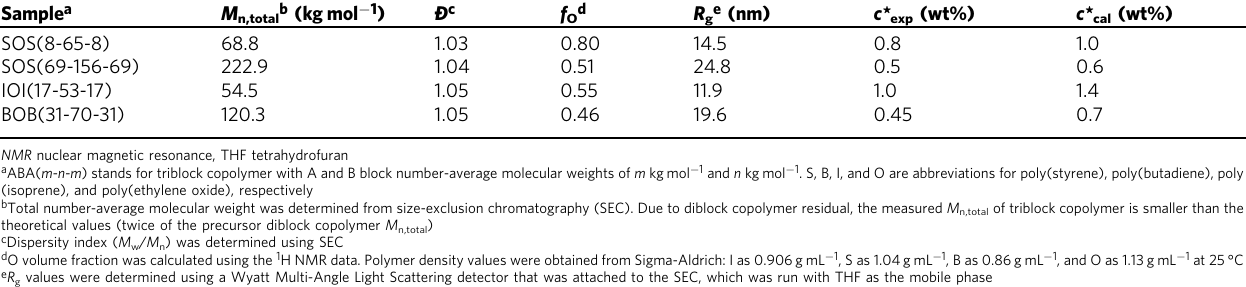
overlap concentration ( c / c *, where c * is η sp = 1), the same three